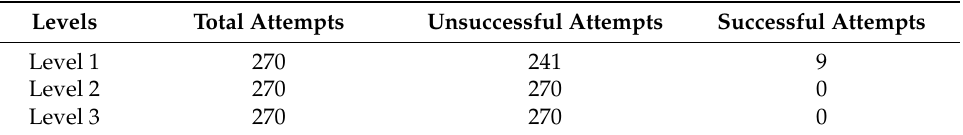
Table 7. Breach Complexity of